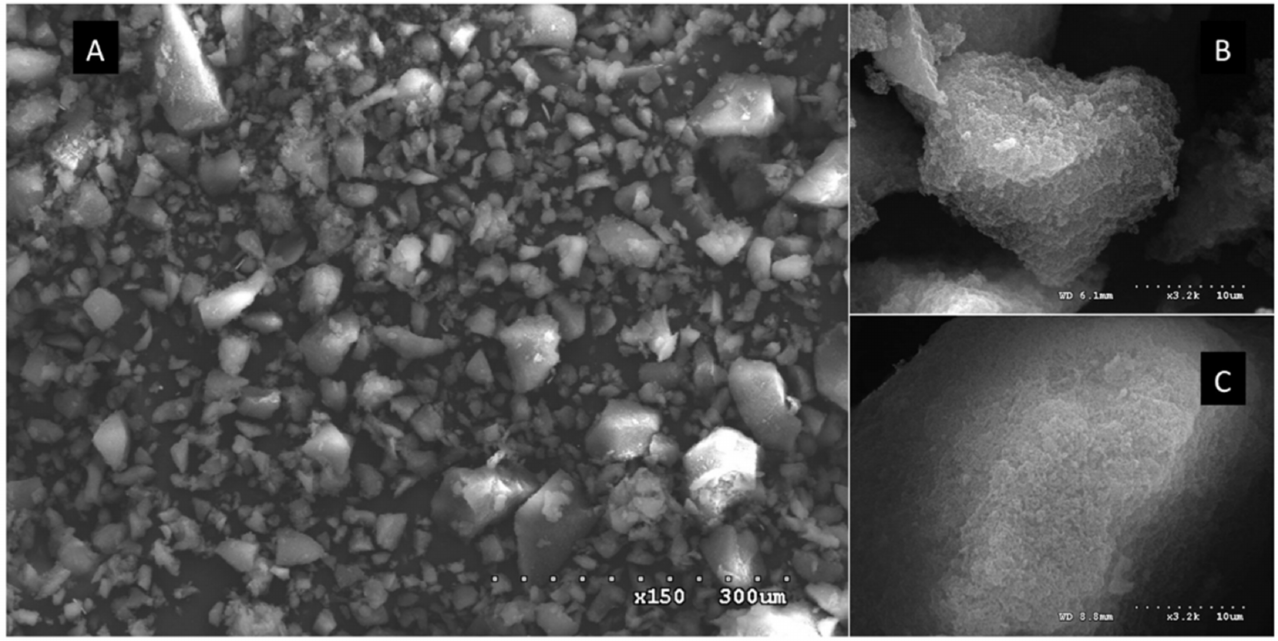
Figure 3. SEM microscopic images of crushed polymers produced by bulk polymerization method. ( A ) and ( B ) show MIP particles, magnification × 150 and × 3200, respectively, while ( C ) shows NIP particles, magnification ×